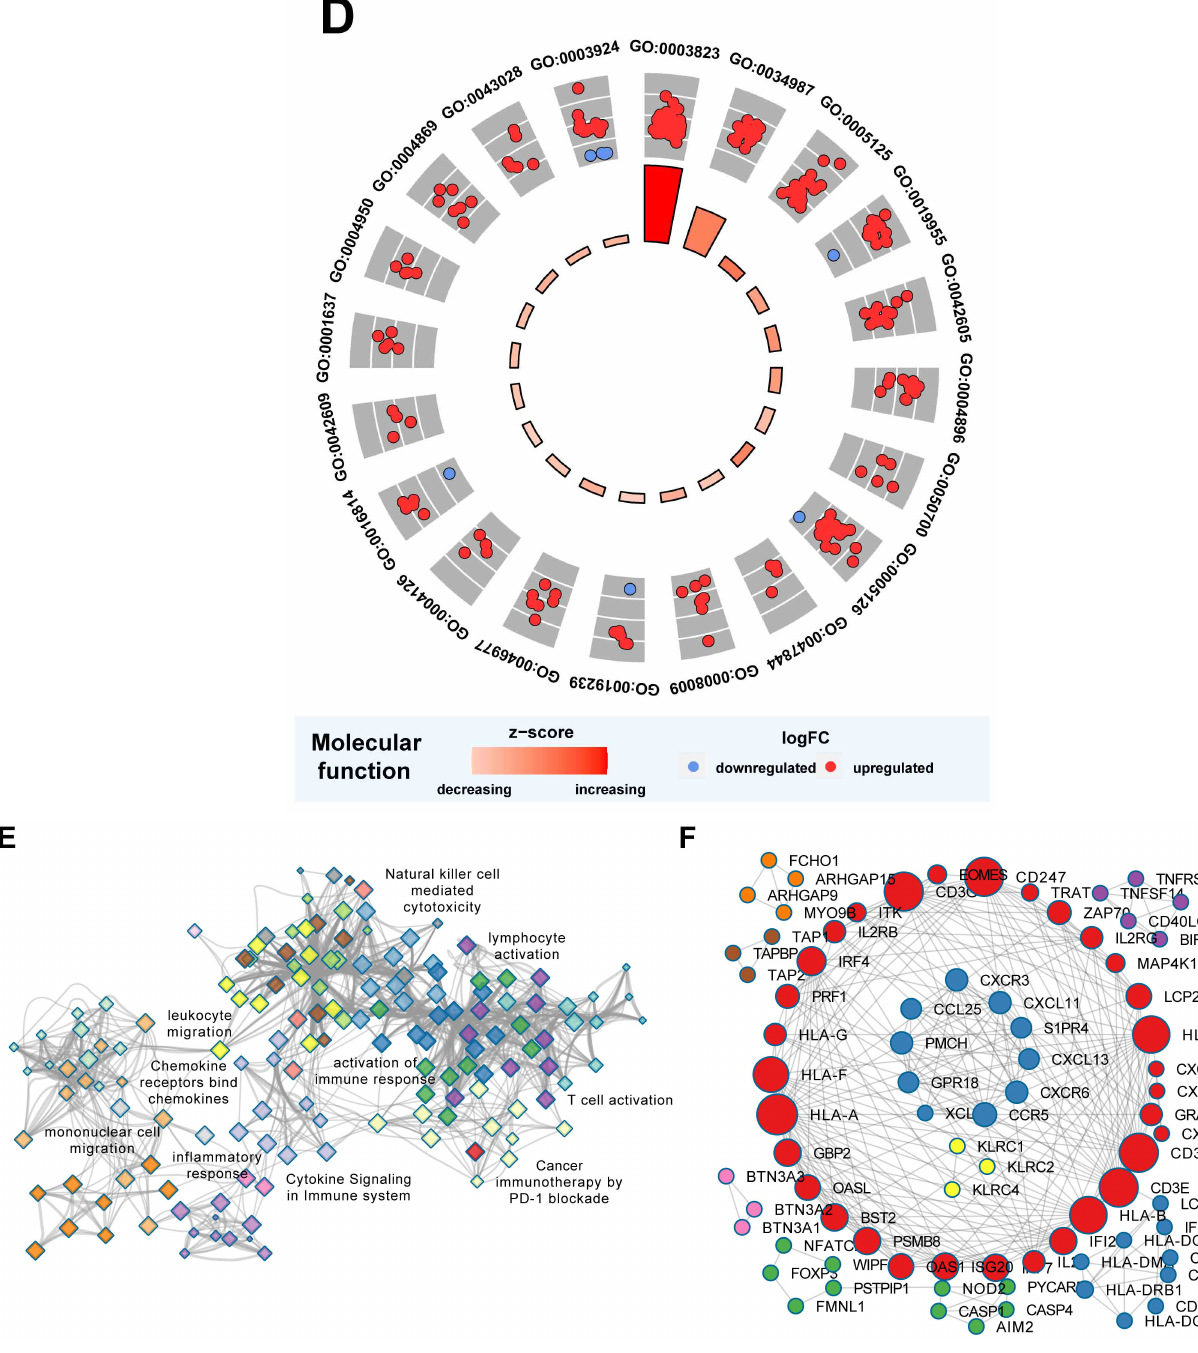
Figure 5. Functional enrichment analysis of RMSGs in the blue module. ( A ) Tree map of the top 20 most significant pathways in KEGG enrichment analysis. ( B ) The top 20 most significant GO terms and relevant genes in biological process are presented. ( C ) The chord diagram displays the top 20 most significant GO terms and involved genes in cell components. ( D ) The circle plot shows the top 20 most significant GO terms in molecular function. ( E ) Network interaction analysis of the signaling pathways using the Metascape database. ( F ) PPI network of RMSGs. RMSGs, resting mast-cell-sensitive genes; KEGG, Kyoto Encyclopedia of Genes and Genomes ; GO, gene ontology; PPI, protein–protein